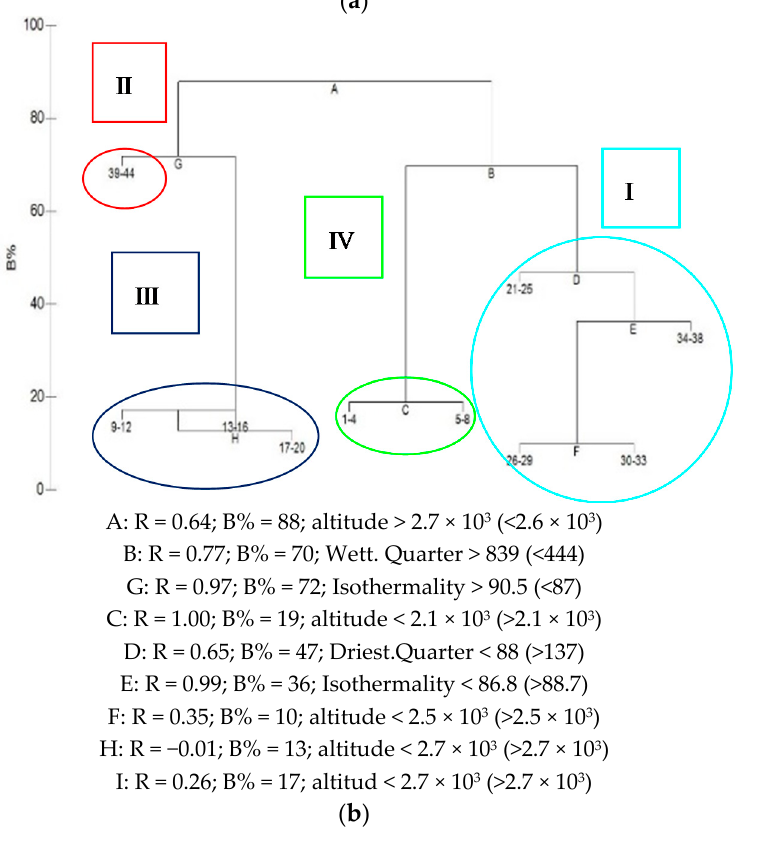
Figure 2. ( a ) Cluster based on floristic similarity using the Bray-Curtis measure (SIMPROF) and ( b ) Dendrogram (LINKTREE) grouping plots based on environment variables and the altitude of montane forests in Southern Ecuador. Use of the same color represents the same floristic group.